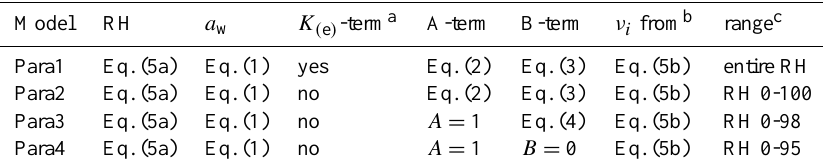
Table 1. Overview of the applied cases using four different water activity, a w -parameterizations.